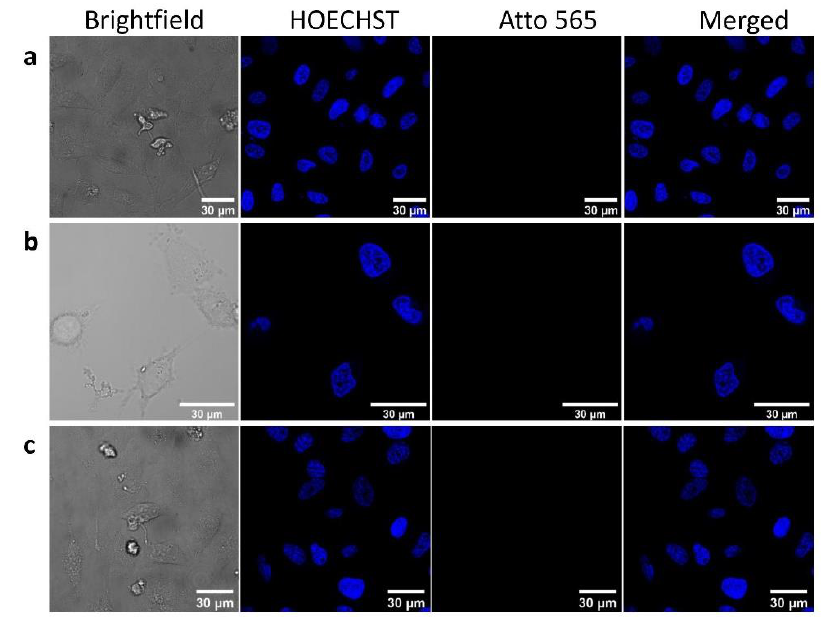
Figure 6. Confocal microscopy images of HeLa cells after treatment by: ( a ) BSA-A565, ( b ) AuNR-BSA-A565, ( c ) AuNPr-BSA-A565 incubated for 24 h. Scale 30 µm. [BSA] = 5 µM, [AuNR-BSA, AuNPr-BSA] = 1 nM. Channels: bright blue (HOECHST), red (Atto-565), blue and red (merged).